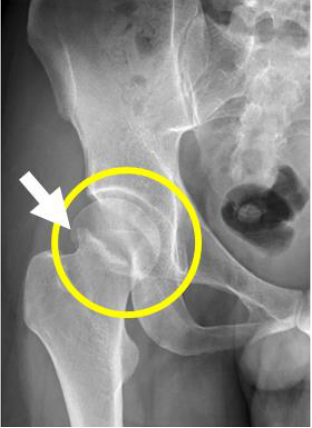
Figure 1. Lateral view X-ray of the right hip femoral neck fracture, Garden type I.